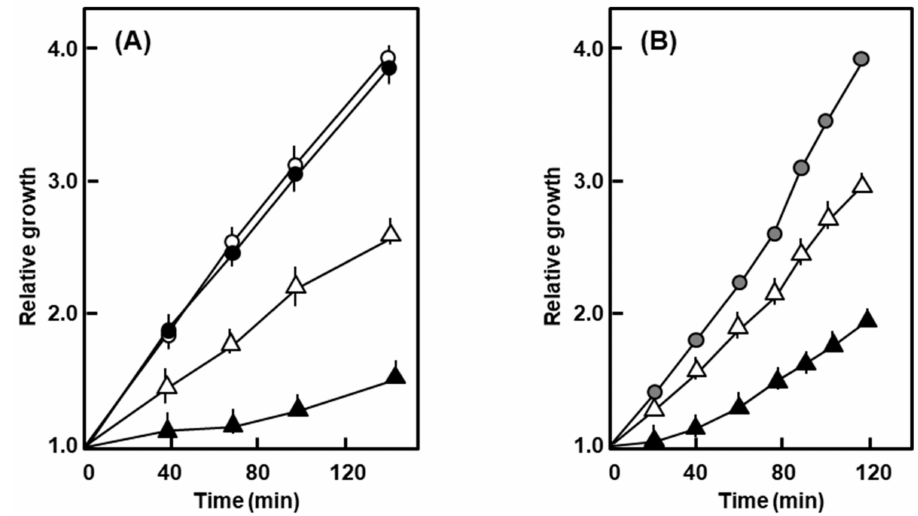
Figure 3. Growth of the polylysogen in the presence of SDS and deoxycholate (DOC). The bacteria were grown in liquid culture in the presence of 0.5% SDS ( A ) and 1% deoxycholate ( B ), and A 590 followed with time. Symbols: nonlysogen, o; polylysogen, ∆ ; empty symbols are for no addition, filled ones are SDS or DOC added. For DOC, the nonlysogen showed a nearly identical growth curve with or without DOC, and therefore, a single graph represents